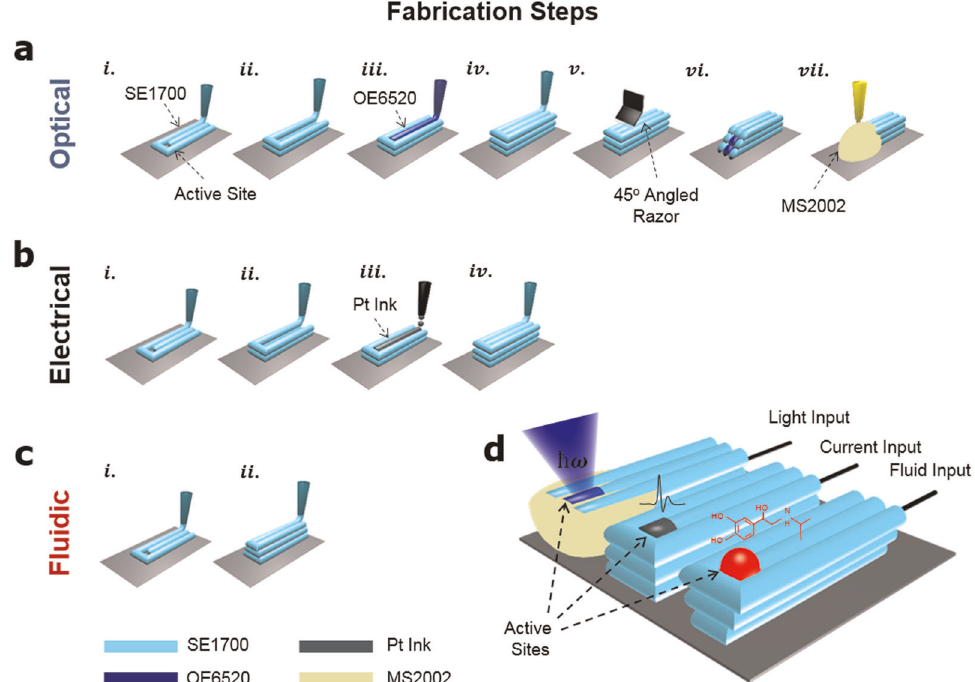
Fig. 2 Multi-material and multi-tool direct ink writing. Algorithm for the production of a optical, b electrical and c micro fl uidic fi bres. The ink palette consists of a structural silicone (SE1700), high RI optical silicone (OE6520), optically re fl ective silicone (MS2002), all from Dow Corning, and a jettable dispersion of platinum microparticles. All printing tools are mounted on the 3DDiscovery bioprinter platform from RegenHU (Switzerland). d Following thermal polymerization, functional fi bres are released from the substrate and inverted to expose active sites. The optical fi bre is coupled with a conventional silica optical fi bre ( Ø 400 μ m). The electrical fi bre is coupled with a Te fl on-coated steel wire. The fl uidic fi bre is coupled with a silicone tubing ( Ø 200 μ